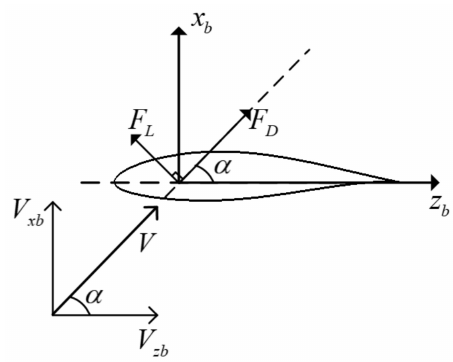
Figure 2. Diagram of aerodynamic force at a blade